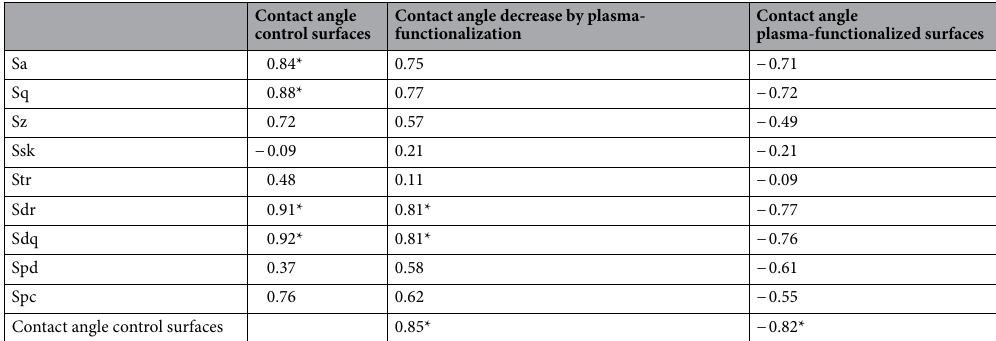
Table 1. Correlation between topographical surface parameters (of the control surfaces) and the contact angles (of functionalized and control surfaces). The table lists the values obtained for the Pearson´s Correlation Coefficient. Statistically significant correlations (two-tailed t-test, p < 0.05) are marked with asterisks. The Pearson´s test for correlation provides values ranging from − 1 to 1, whereby values close to − 1 suggest an inverse correlation, values around 0 reject any correlation and values close to 1 point at strong correlation between two parameters.